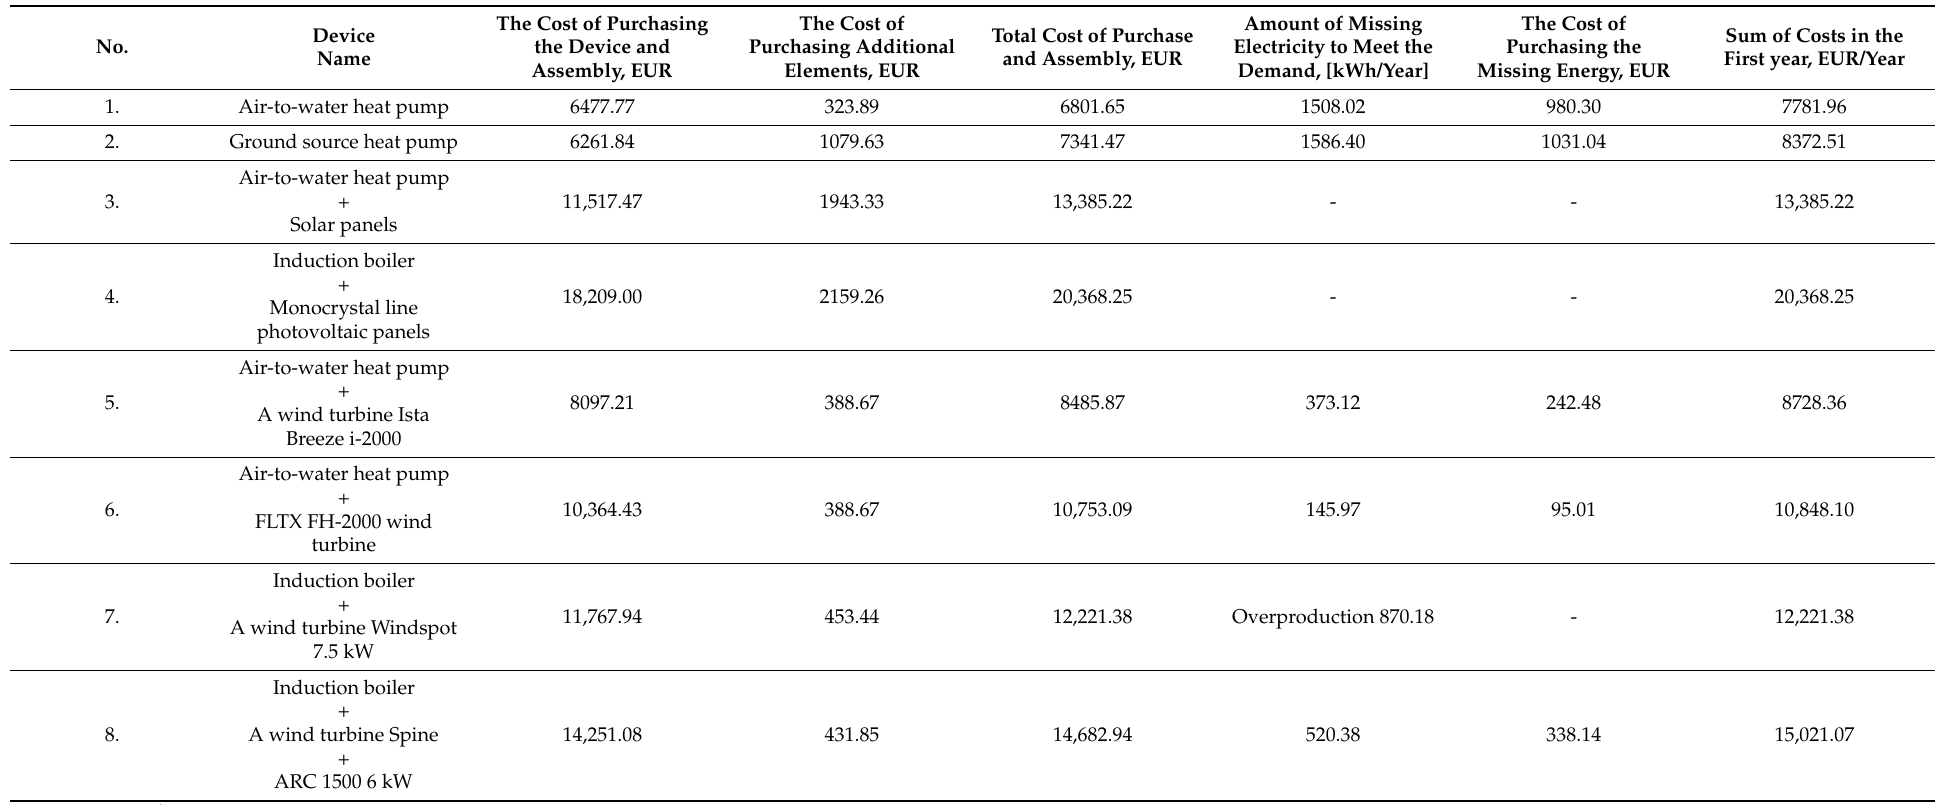
Table 17. Purchase costs of the applied